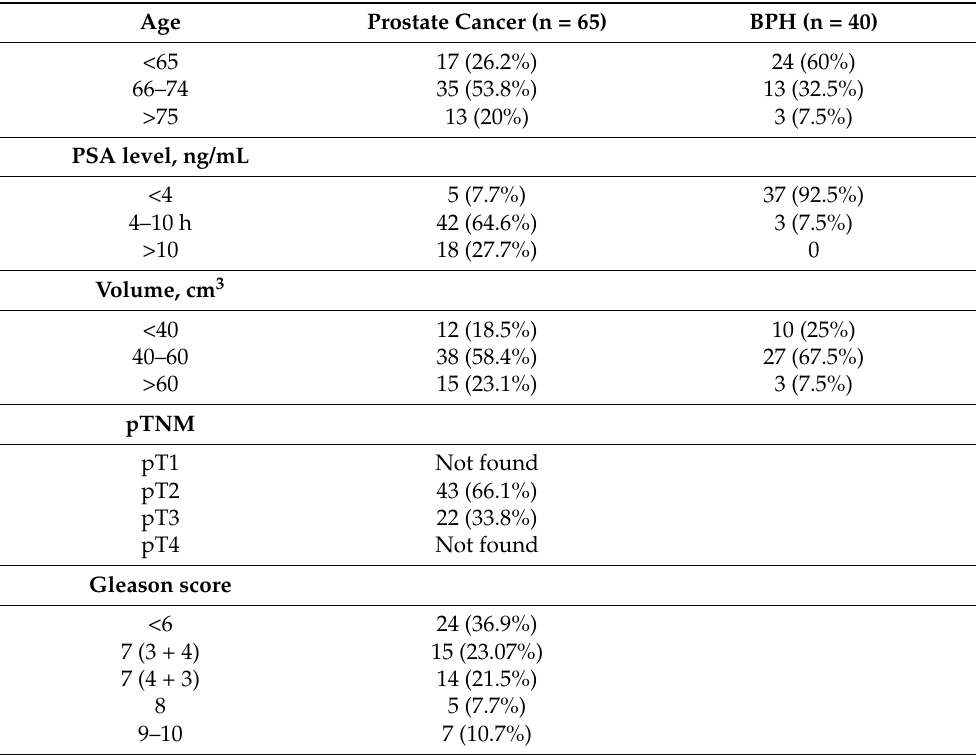
Table 1. Clinical and morphological characteristics of patients with PC and